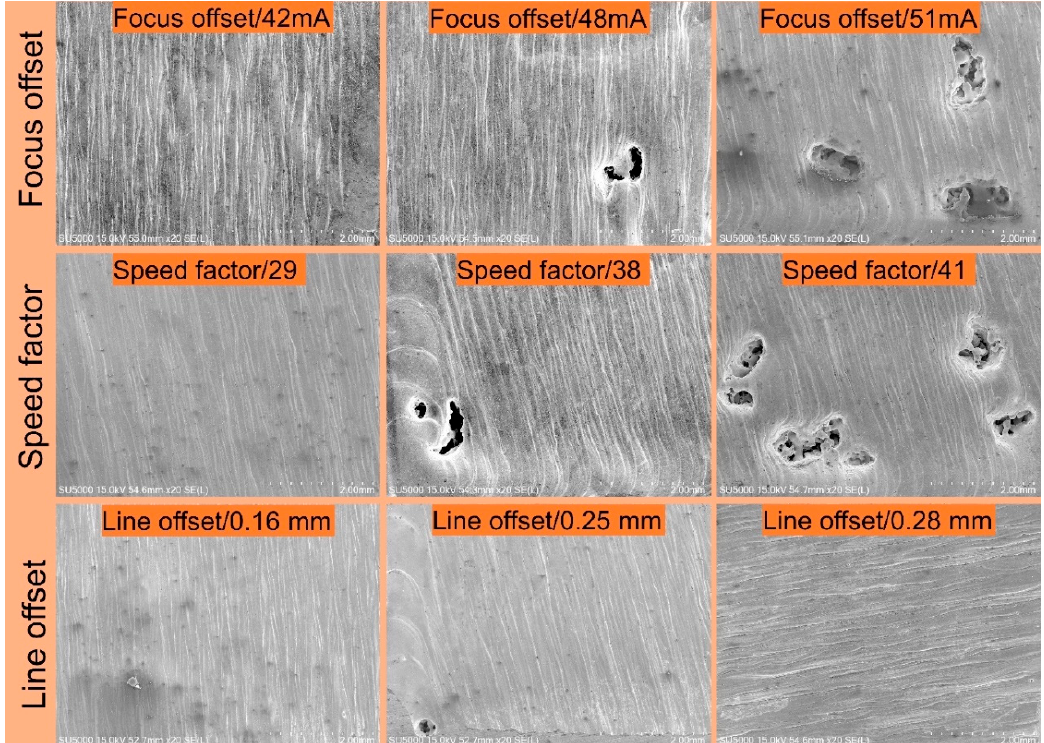
Figure 3. Effect of various process parameters on the surface morphology of electron beam melting Figure 3. E ff ect of various process parameters on the surface morphology of electron beam technology (EBM) Ti-6Al-4V specimens. melting technology (EBM) Ti-6Al-4V specimens.